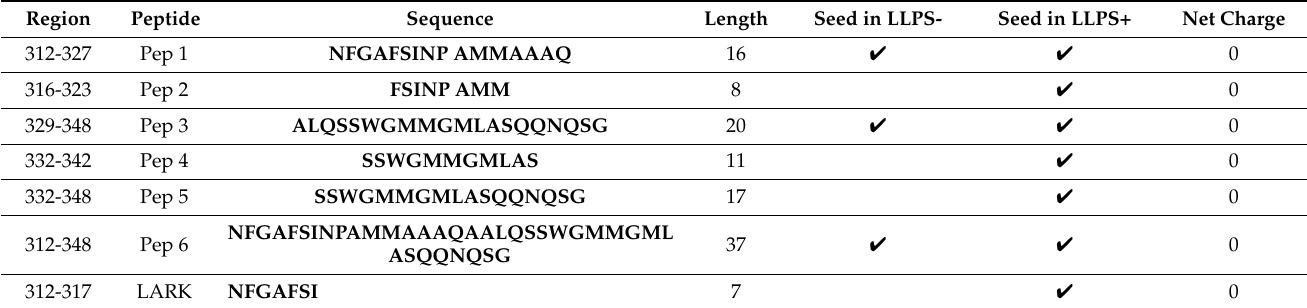
Table 1. Characteristics and effects of the peptides selected for seeding in LLPS+ and LLPS-